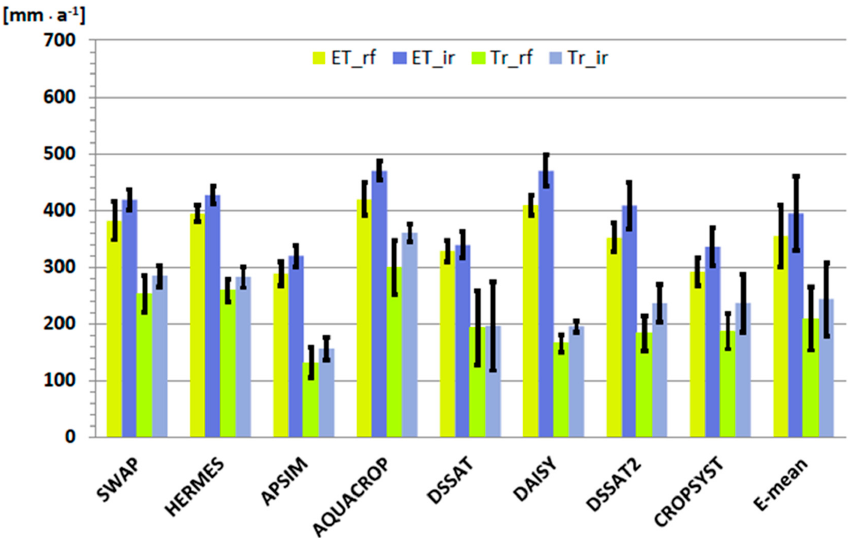
Figure 2. Simulated evapotranspiration (ET) and transpiration (Tr) for rainfed (_rf) and irrigated (_ir) variants of the Müncheberg field experiment from different models. Error bars of the model results show inter-annual variability, error bars of the ensemble mean the inter-model variability. Water 2016 , 8 , 571